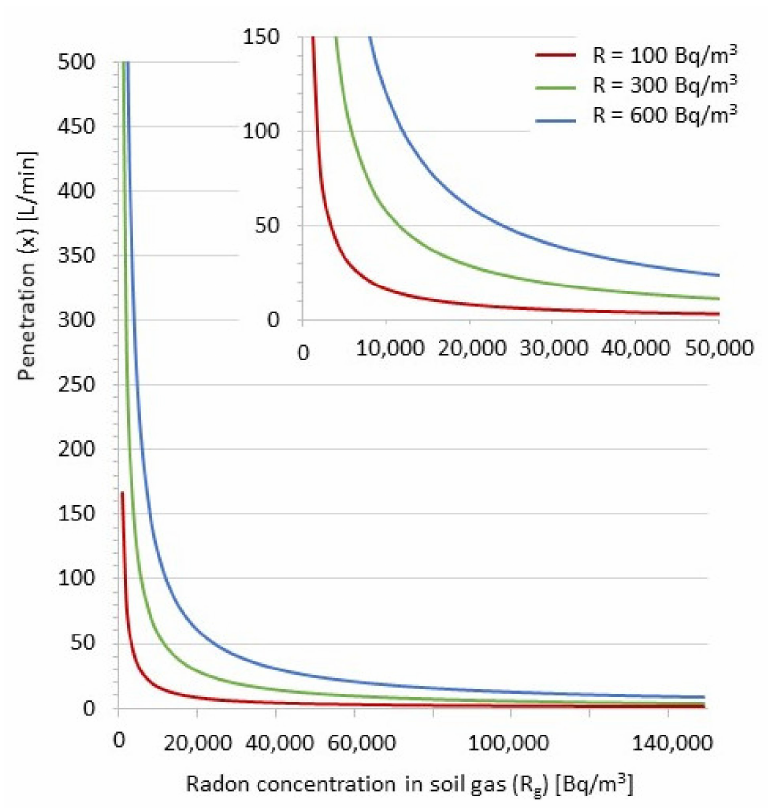
Figure 4. Soil gas penetration, balancing an acceptable radon concentration in indoor air of 100, 300, and 600 Bq/m 3 . Soil gas contains radon. Indoor air was diluted with outdoor air. Outdoor air contains 5 Bq/m 3 radon. The air-change rate was 0.5 h − 1 . The initial radon contribution from indoor materials (R im ) was 40 Bq/m 3 , providing a radon contribution from indoor materials (R m ) of 8 Bq/m 3 to the radon indoor-air concentration. The house has a ground area of 100 m 2 and a ceiling height of 2.5